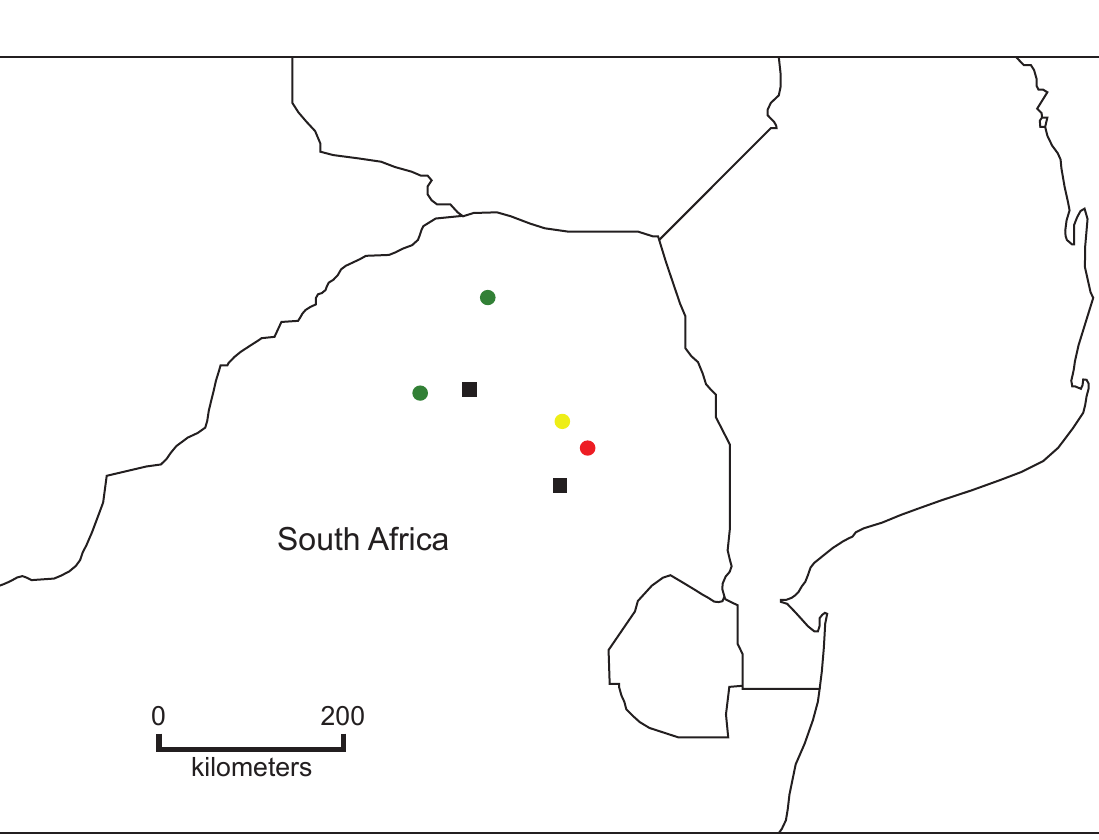
Fig. 14. distribution of species of Ballomma gen. nov.: B. erasmus gen. et sp. nov. ( ), B. haddadi